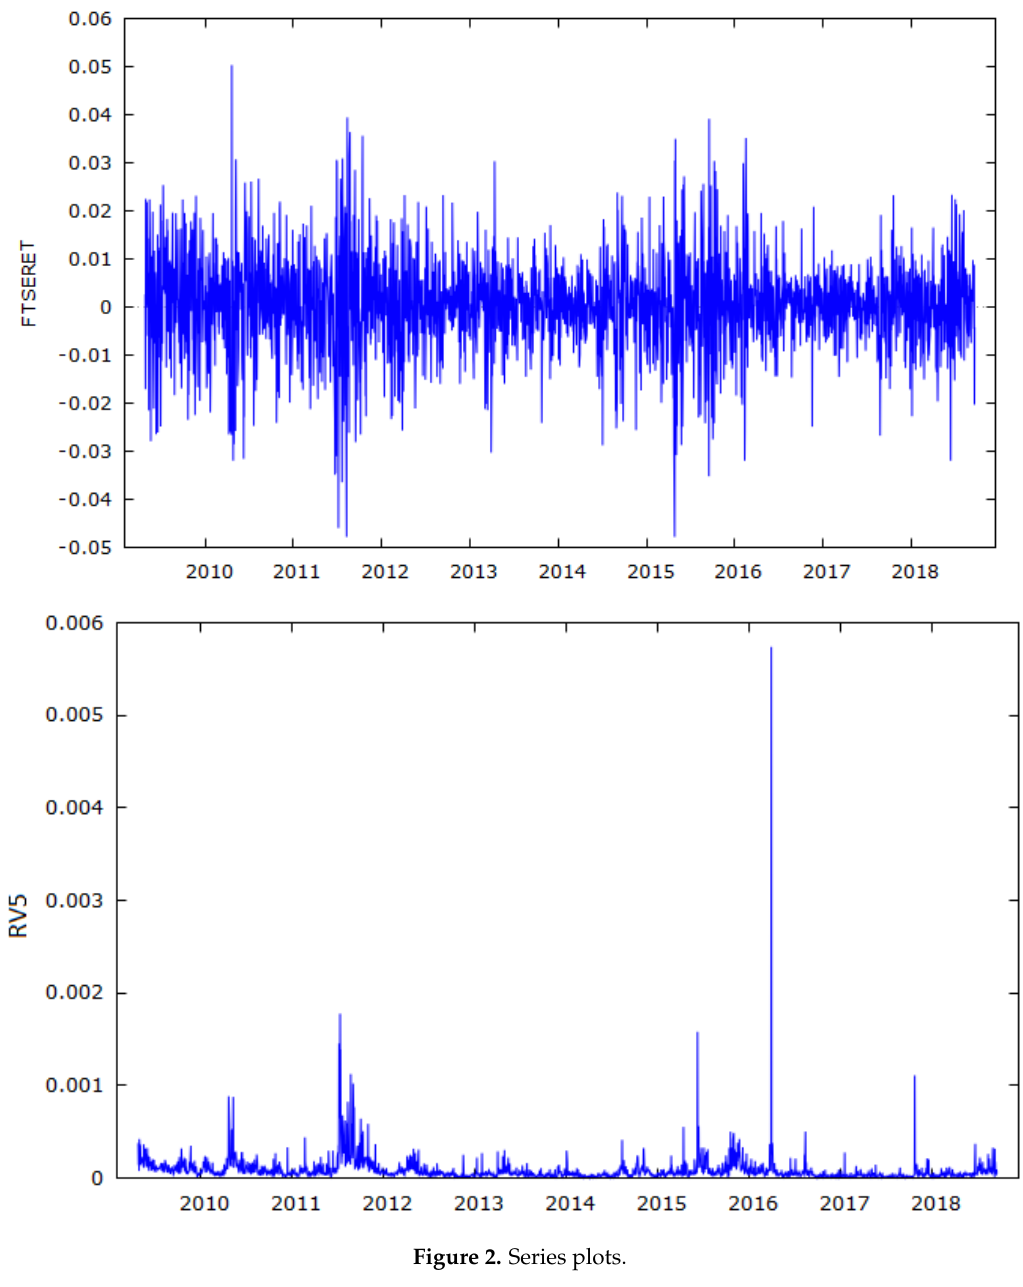
Figure 2. Series